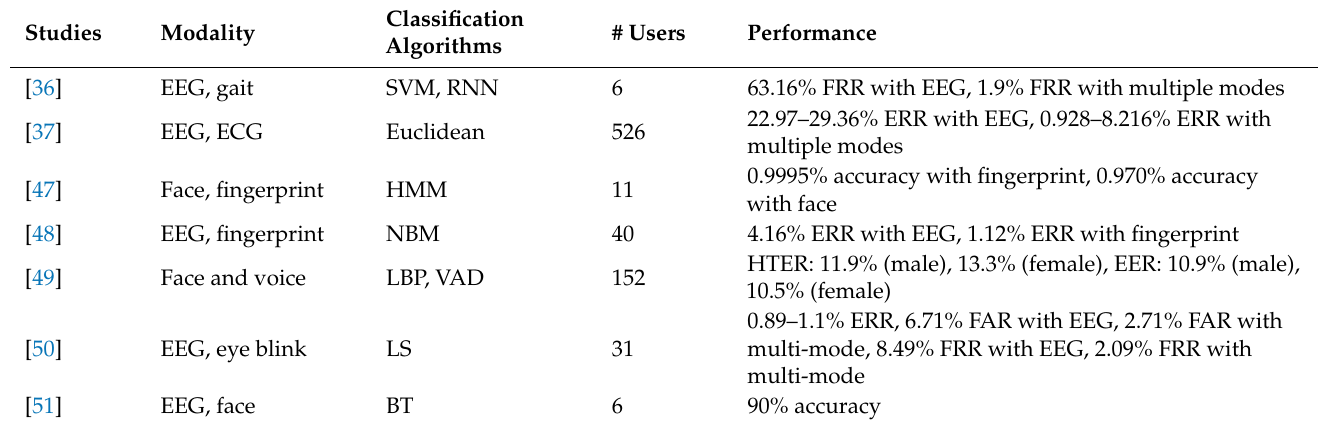
Table 3. MultiModal